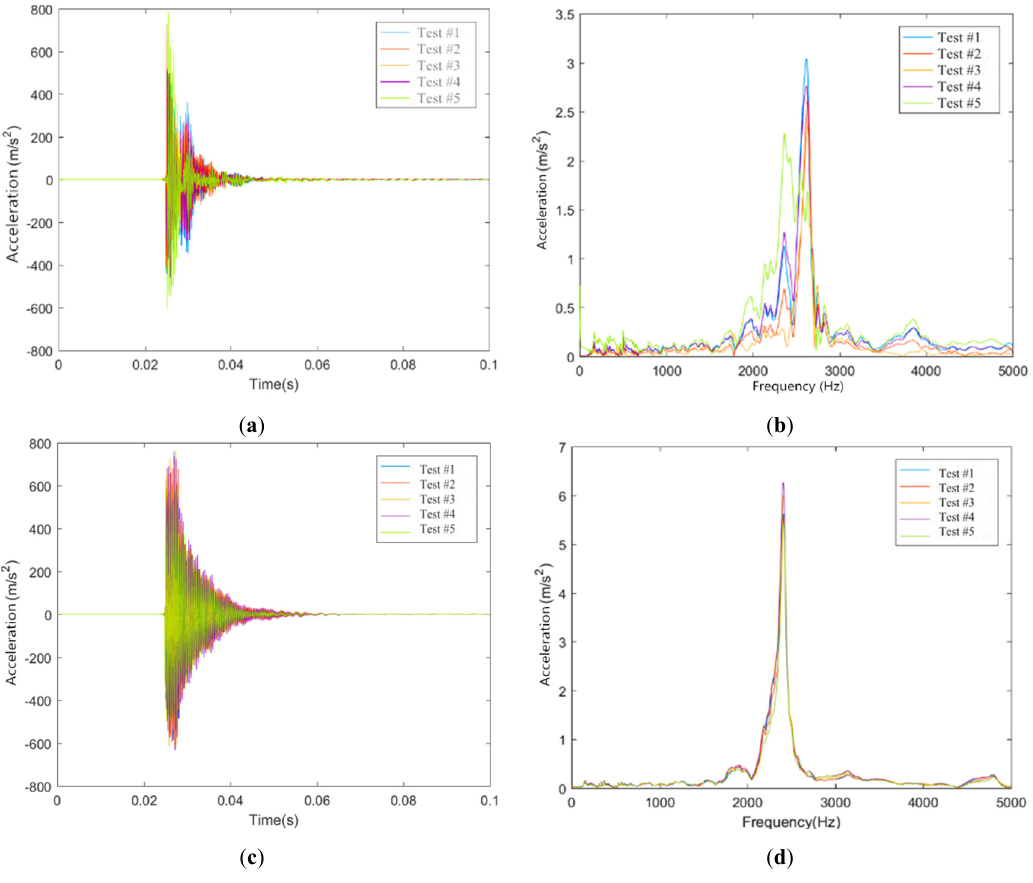
Figure 7. Vibration characteristics of rails. ( a ) Time-domain measuring data of sensor R1F1 in Condition #1; ( b ) Frequency-domain measuring data of sensor R1F1 in Condition #1; ( c ) Time-domain measuring data of sensor R1J1 in Condition #2; ( d ) Frequency-domain measuring data of sensor R1J1 in Condition #2.